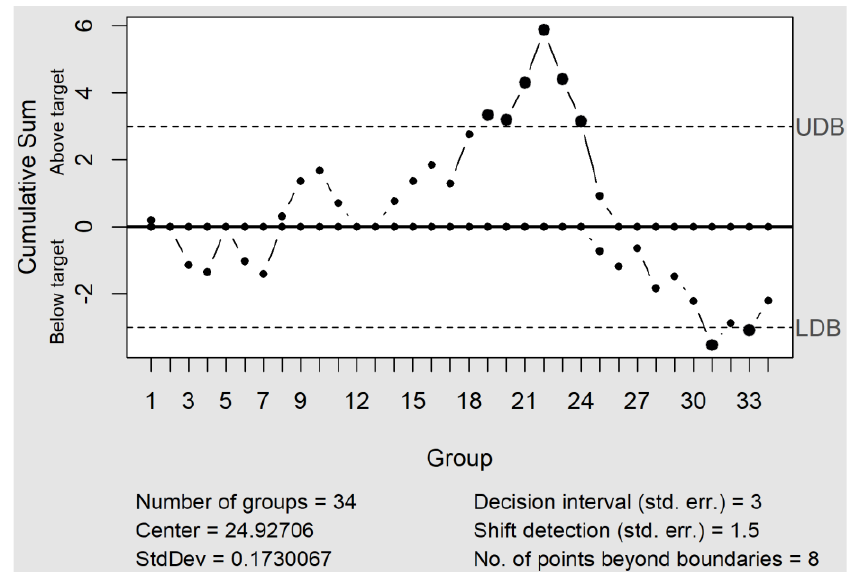
Figure 4. The CuSum control chart shows two altered zones (in red). The first shows an upward tendency (C+) related to a column change, and the second shows a downward tendency (C−), due to the introduction of a new bevacizumab lot. UDB and LDB are the upper and lower control limits. At first, the CuSum control chart performed better for detecting shifts lower than 1.5 SD.